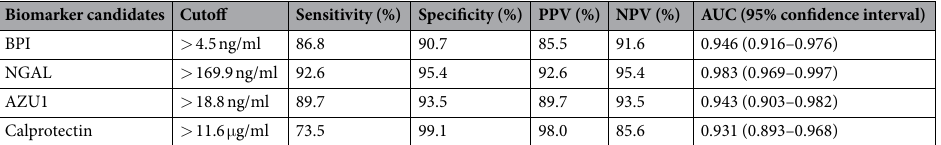
Biomarker candidates Cutoff